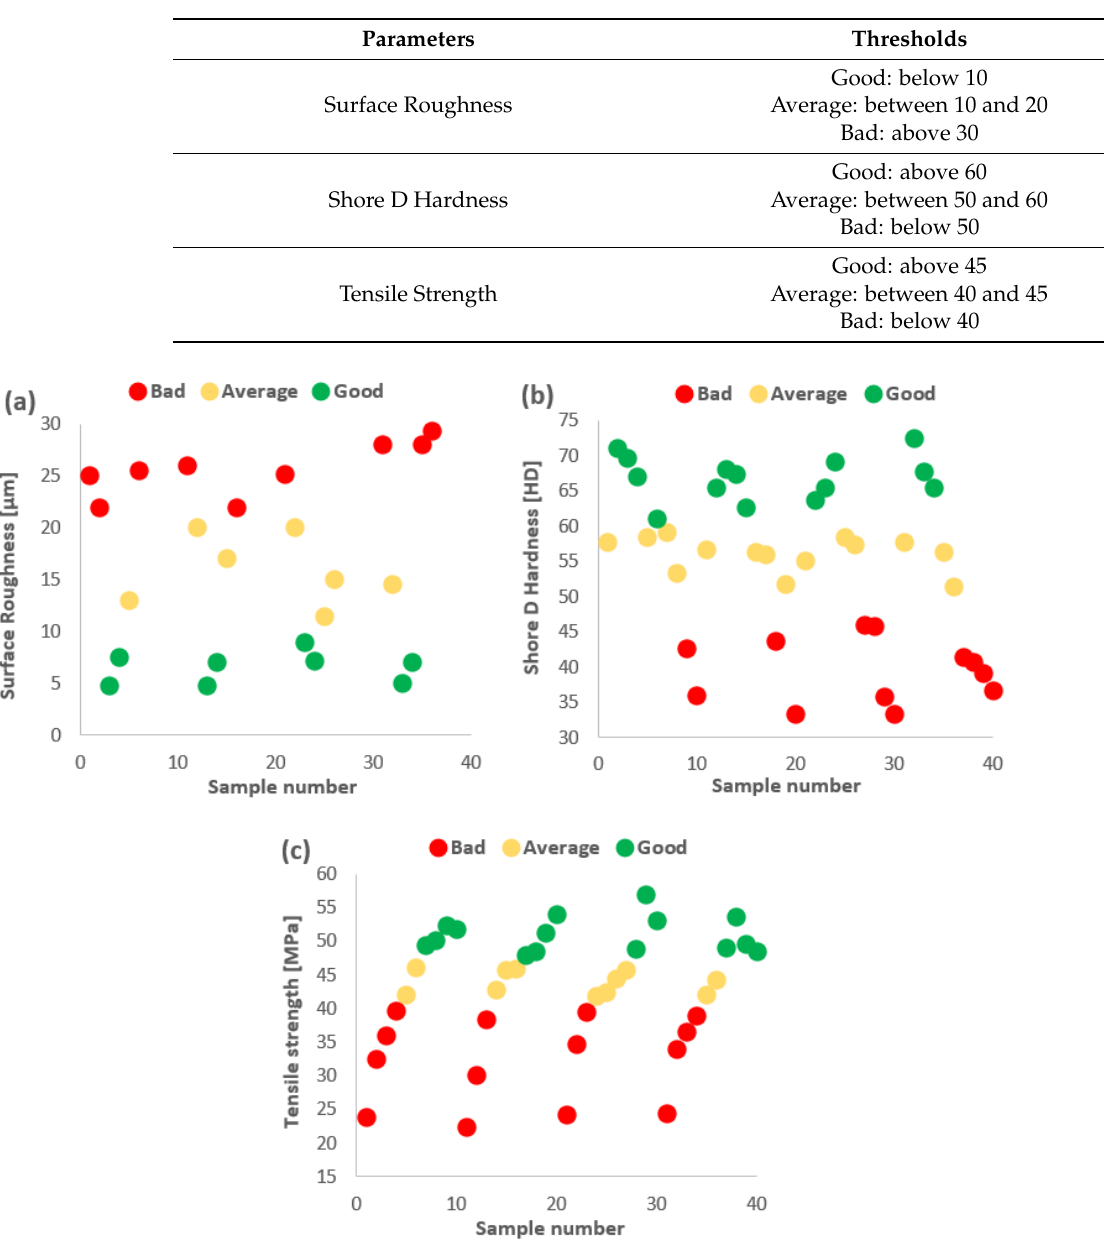
Table 9. Thresholds for categorization.